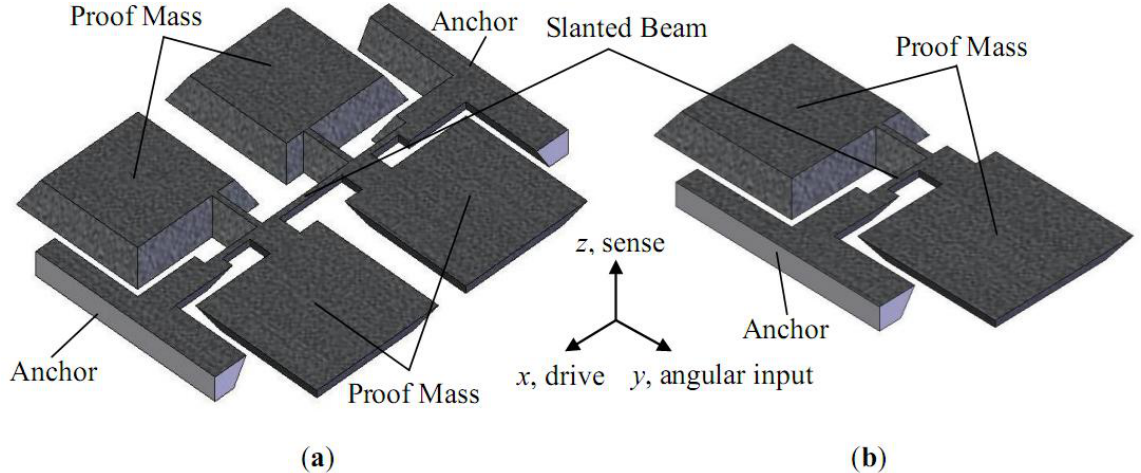
Figure 1. Schematic sketch of the gyroscopes. (a) clamped-clamped beam (b) clamped-free beam.